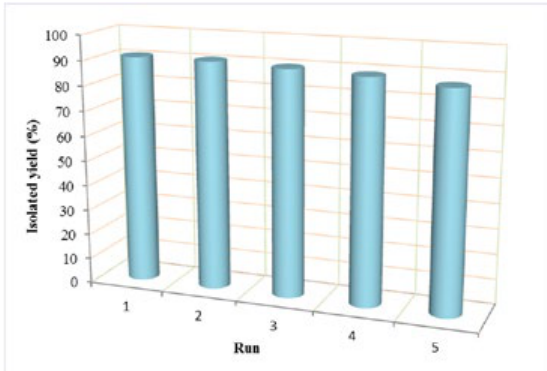
Fig. 1. Reusability of {[2,2'-BPyH][C(CN) 3 ] 2 } in the synthesis of 3,4-dihydropyrano[ c ]chromene for the model reaction in 10 min.